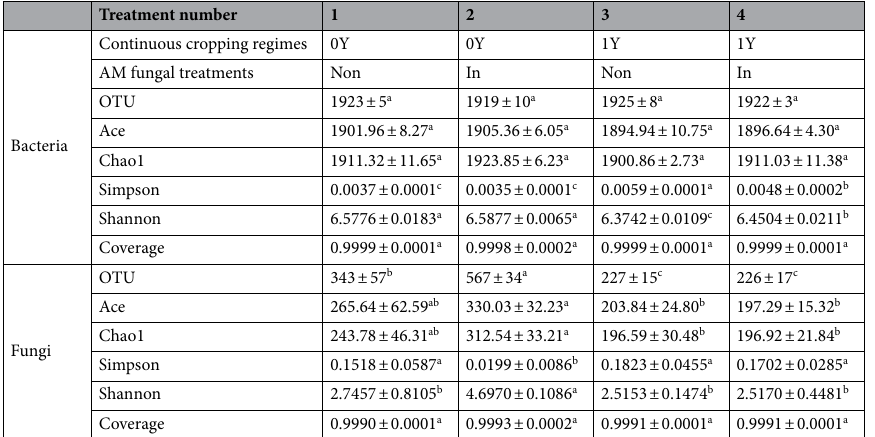
Table 4. Factorial design results of diversity indices of bacteria and fungi in different samples. 0Y and 1Y represent 0 year and 1 year of continuous cropping, respectively. Non represents non-inoculated with R. intraradices . In represents inoculated with R. intraradices . Different letters indicate significant differences from different treatments ( P <